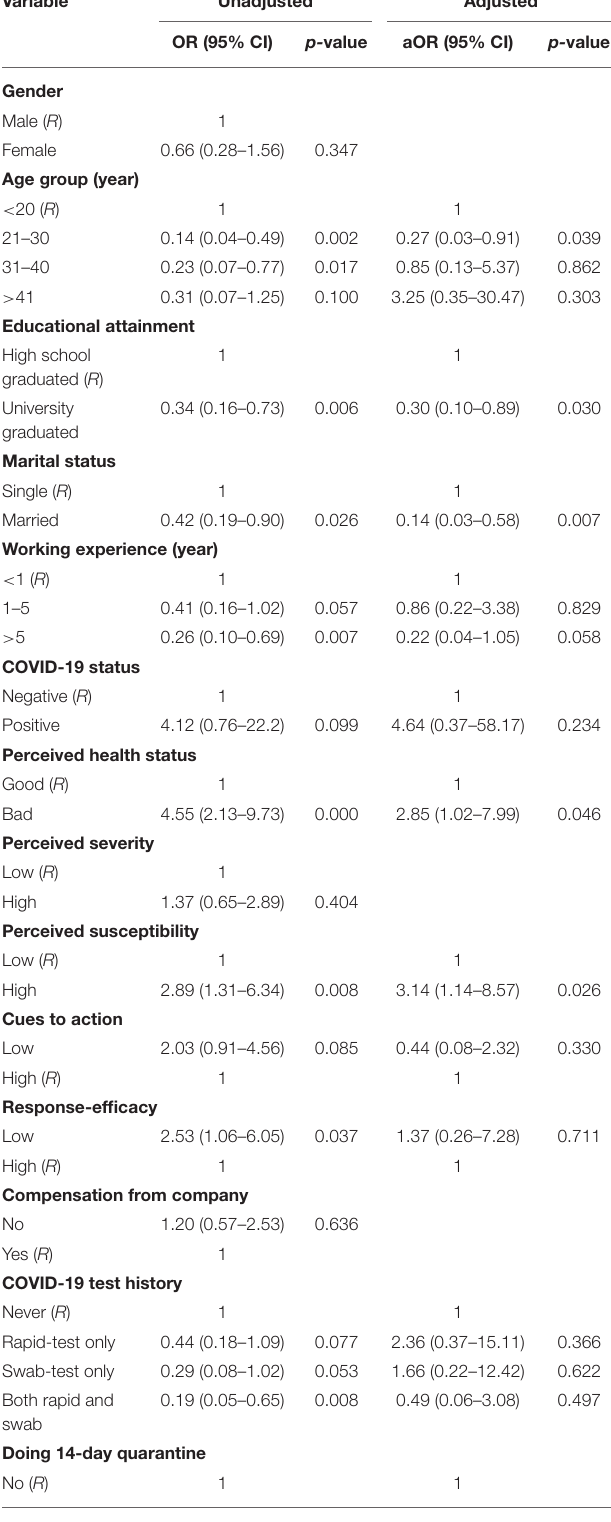
TABLE 3 | Unadjusted and adjusted logistic regression analysis showing factors associated with anxiety during COVID-19 ( n = 335).